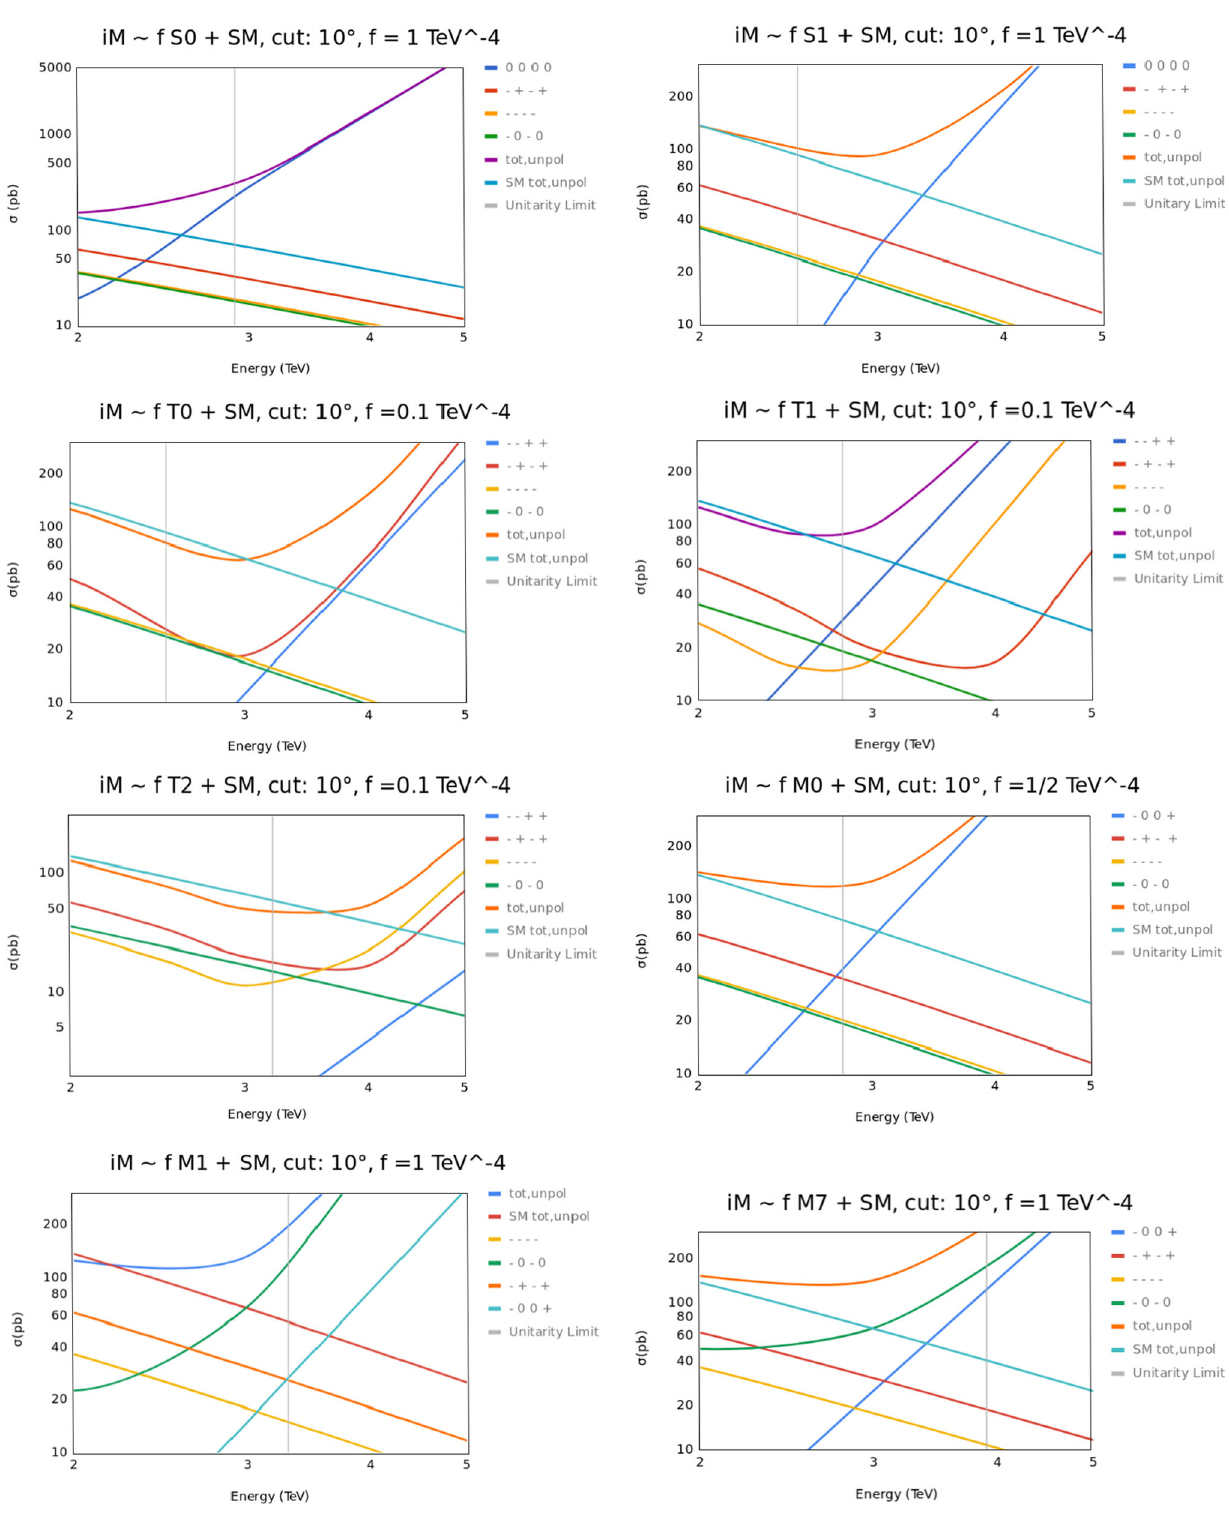
Fig. 6 Contributionsofthepolarizedcrosssections(multiplicitytaken into account) as functions of the center-of-mass collision energy √ s , in TeV) for chosen values of f i > 0. The remaining ( E CM ≡